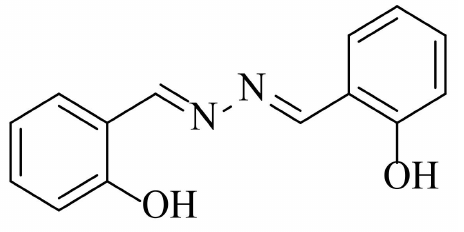
Figure 1. Molecular structure of salicylalazine purified from M. biflora